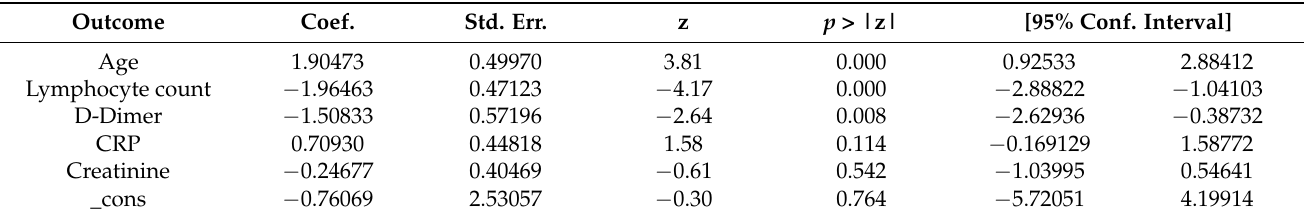
Table 5. The logistic regression